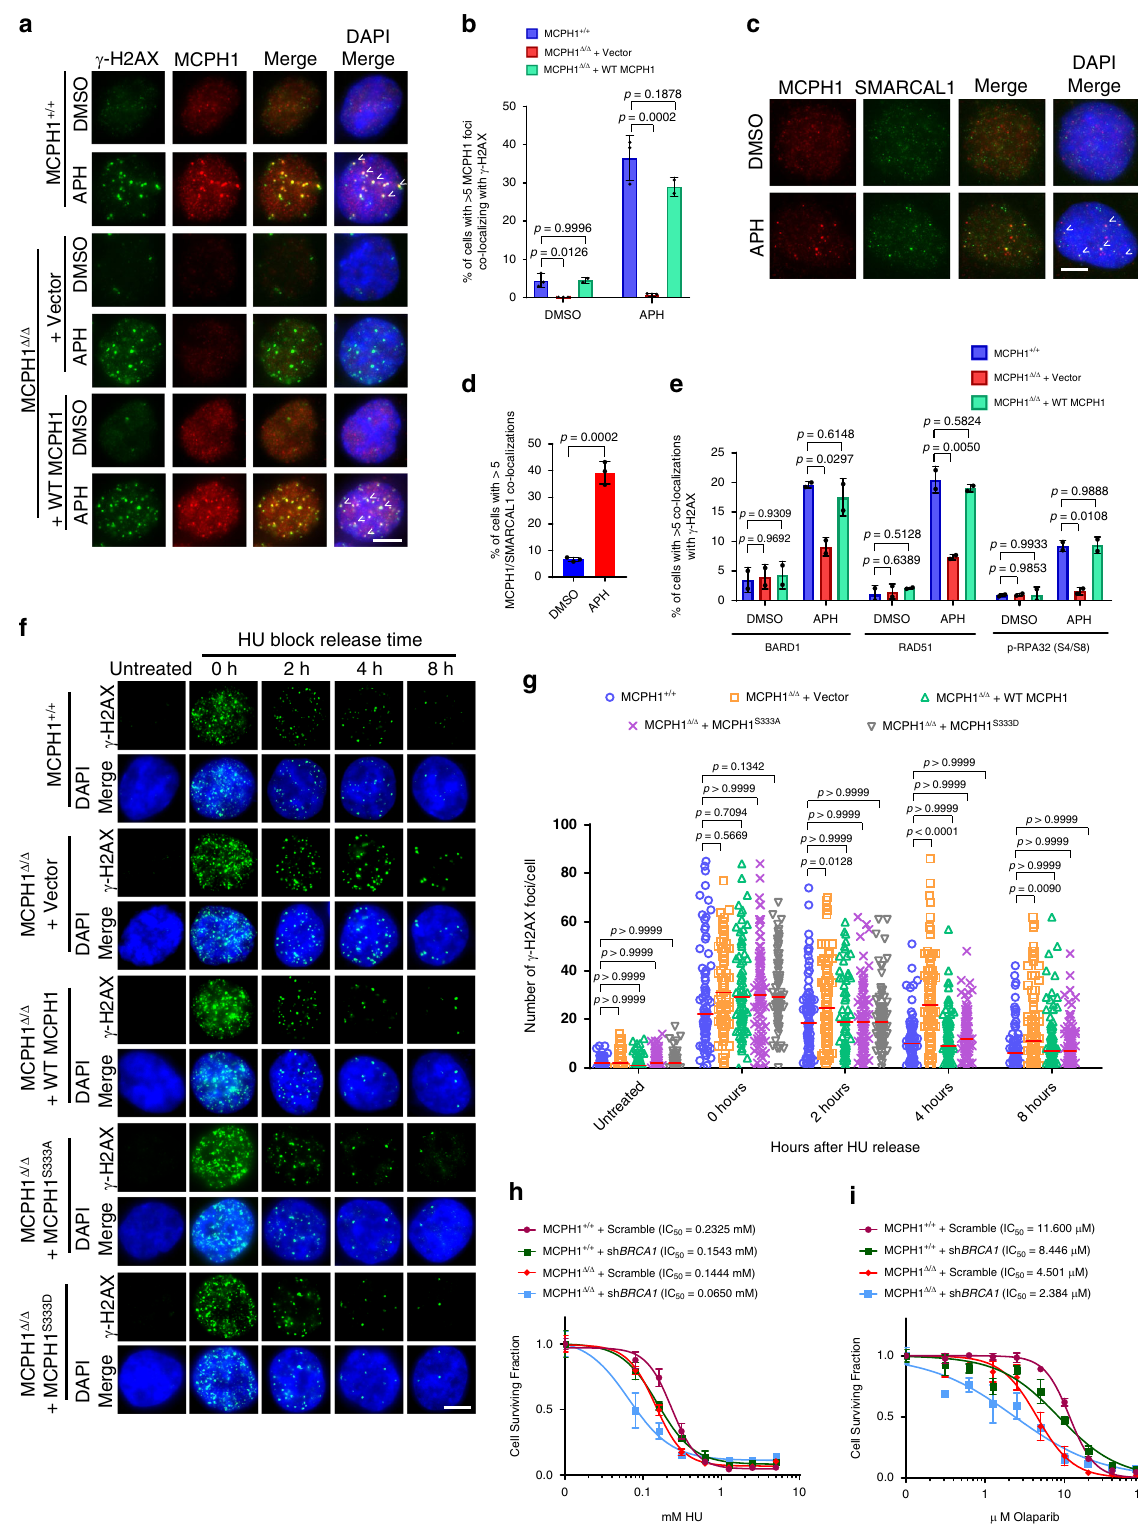
replication forks is delayed. In addition, MCPH1 co-localizes with SMARCAL1 in response to replication stress and readily localizes to TRF1-depleted telomeres, further suggesting that MCPH1 recognizes stalled replication forks both at genomic DNA and at telomeres. Our data also show that MCPH1 promotes end resection and recruitment of HDR factors to genomic